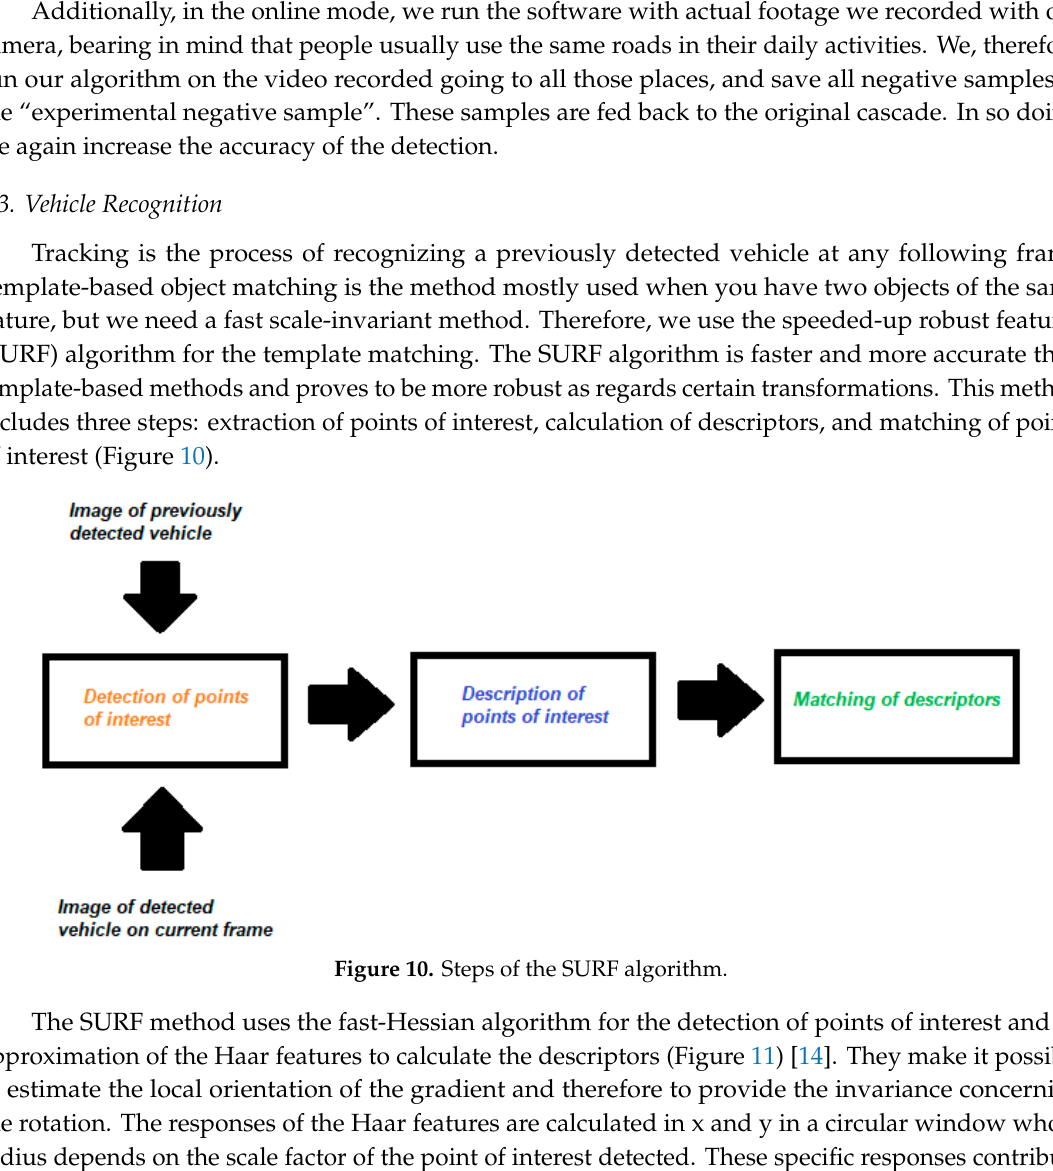
Figure 9. Feedback Adaboost system.